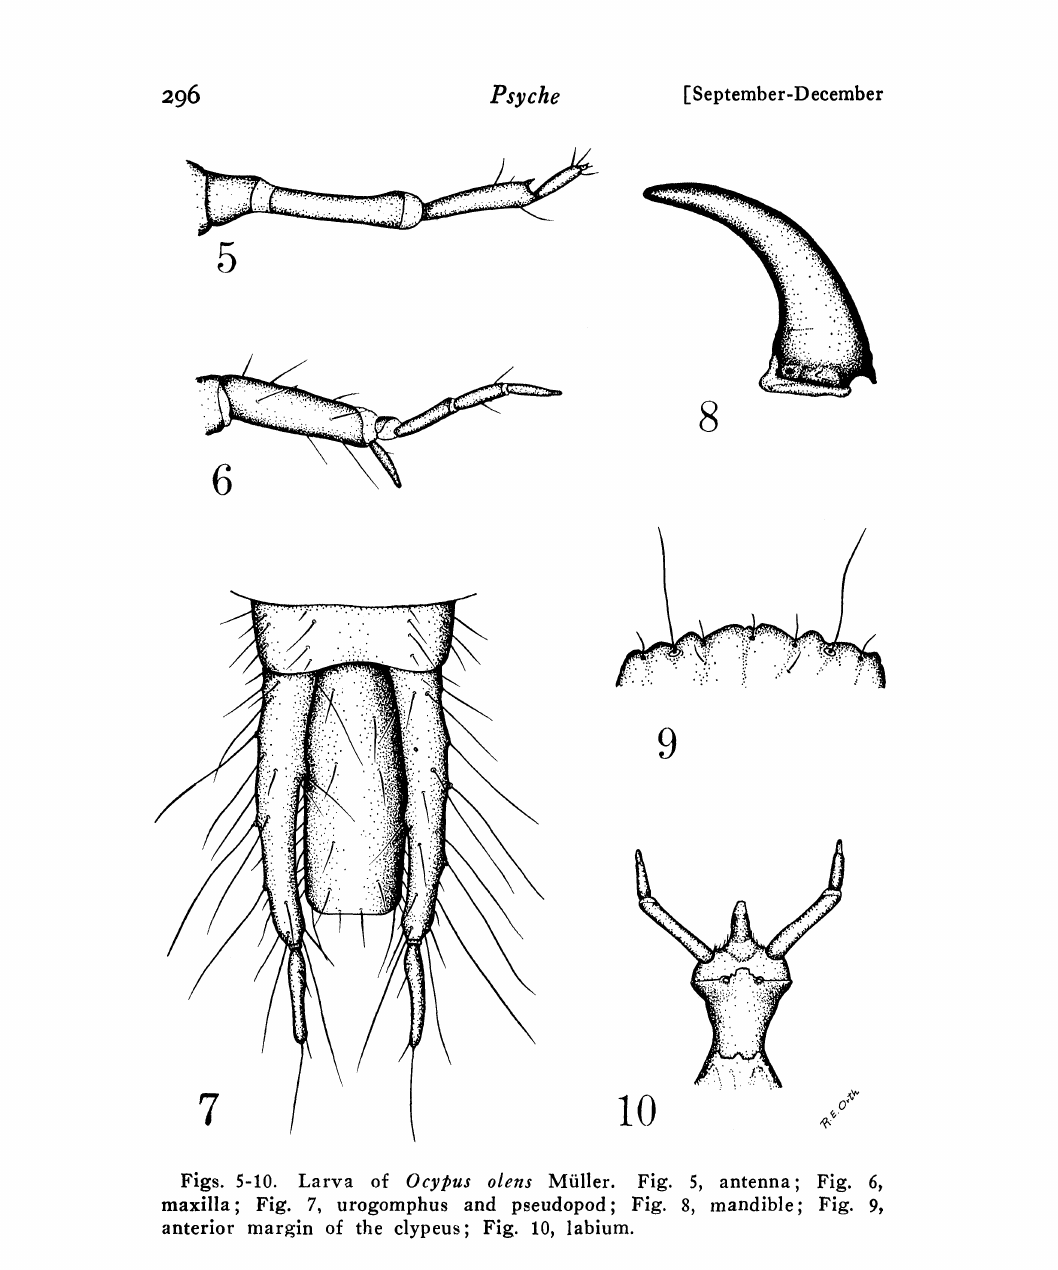
Figs. 5-10. Larva of Ocylus olens Mfiller. Fig. 5, antenna; Fig. 6, maxilla; Fig. 7, urogomphus and pseudopod; Fig. 8, mandible; Fig. 9, anterior margin of the clypeus; Fig. 10,